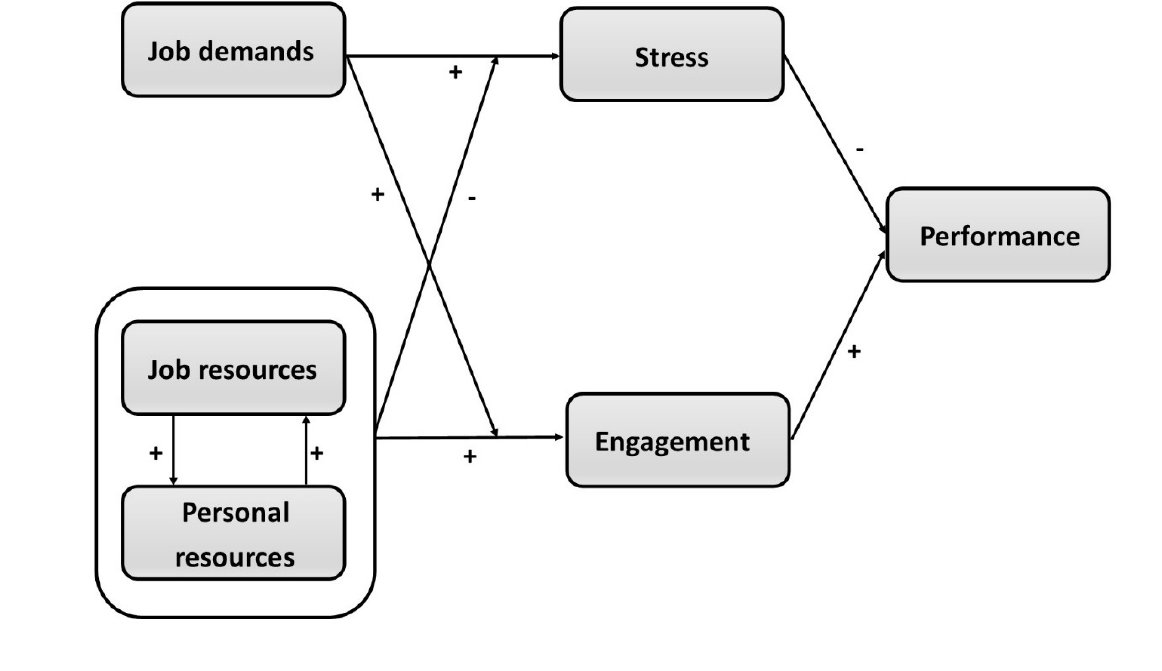
Figure 1 . The Job Demands-Resources